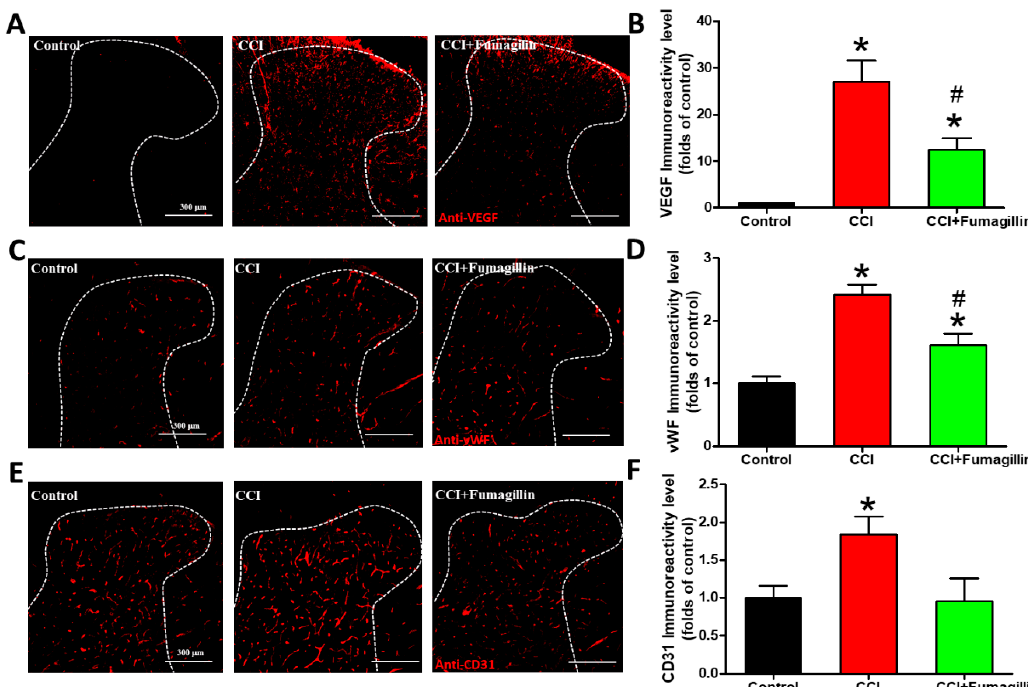
Figure 6. Effect of intrathecal administration of fumagillin on chronic constriction injury (CCI) − induced angiogenesis. Lumbar spinal cords were obtained at postoperative day (POD) 14 after the last intrathecal injection from control, CCI, and CCI + fumagillin groups. Immunofluorescence images show cells labeled with vascular endothelial growth factor (VEGF) (red; A ), von Willebrand factor (vWF) (red; C ), and cluster of differentiation 31 (CD31) (red; E ) in the ipsilateral spinal cord dorsal horn (SCDH) (20 − µ m sections; magnification: 100 × ; scale bars: 300 µ m). Quantification of VEGF ( B ), vWF ( D ), and CD31 ( F ) immunoreactivities are shown as means ± standard error of means (SEMs) (4 sections per rat, 3 rats per group). * p < 0.05 compared with the control group; # p < 0.05 compared with the CCI group; one − way analysis of variance (ANOVA) with post hoc Tukey test.